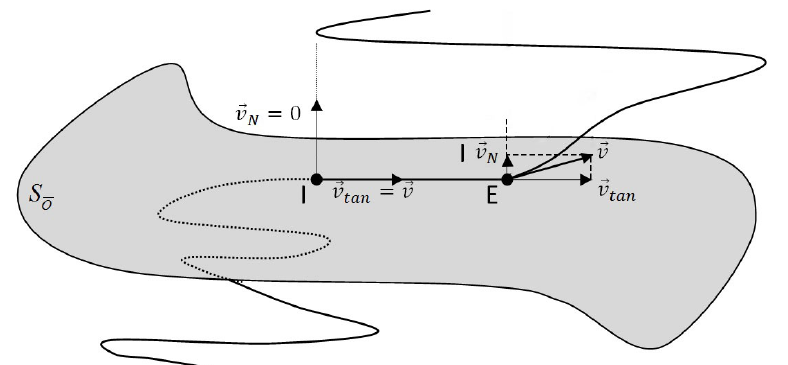
Figure 3. Defining quality observability